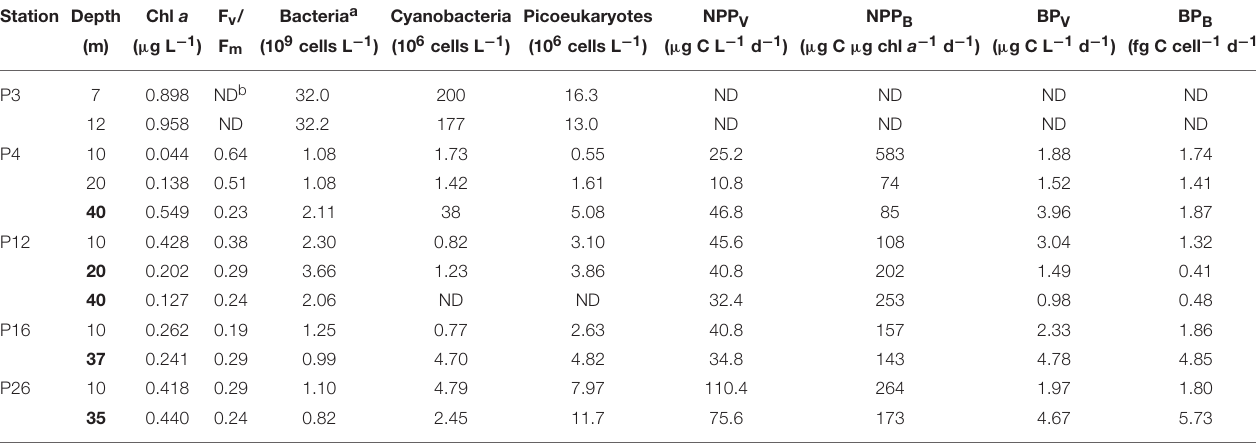
TABLE 4 | Biomass and rate parameters measured at each sampling depth along Line P. Station